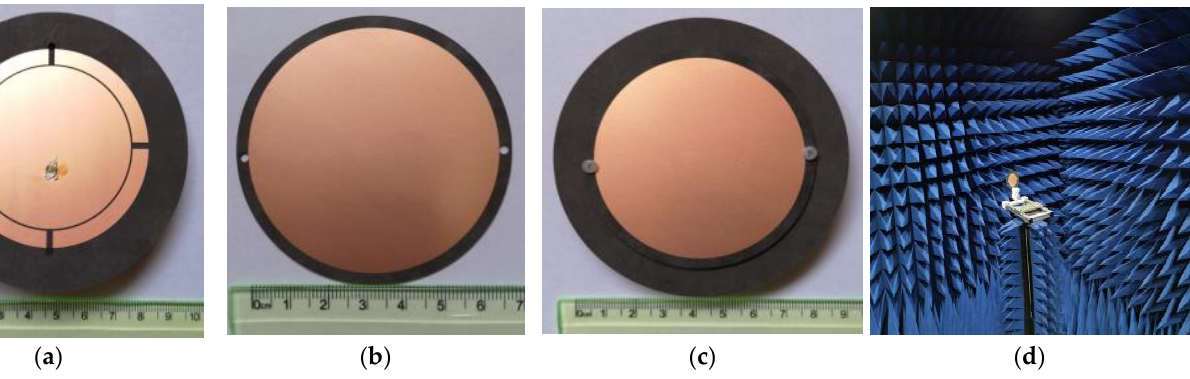
Figure 8. Photography of the fabricated patch antenna: ( a ) top view of Substrate 1; ( b ) top view of Substrate 2; ( c ) top view of the assembled antenna; ( d ) test process of the fabricated antenna.